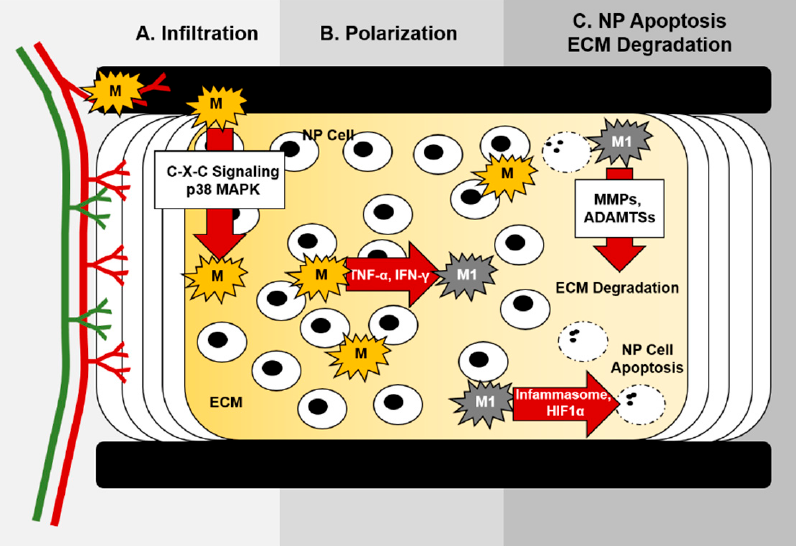
Figure 3. Molecular control of macrophages during intervertebral disc degeneration. ( A ). C-X-C and p38 MAPK signaling promote macrophage infiltration into the IVD during degeneration. ( B ). TNF- α and IFN- γ within the local microenvironment promote M1 polarization during IVD degeneration. ( C ). Inflammasome activation and HIF-1- α signaling influence nucleus pulposus cell apoptosis, and macrophage-produced MMPs and ADAMTSs promote ECM degradation within degenerated discs.